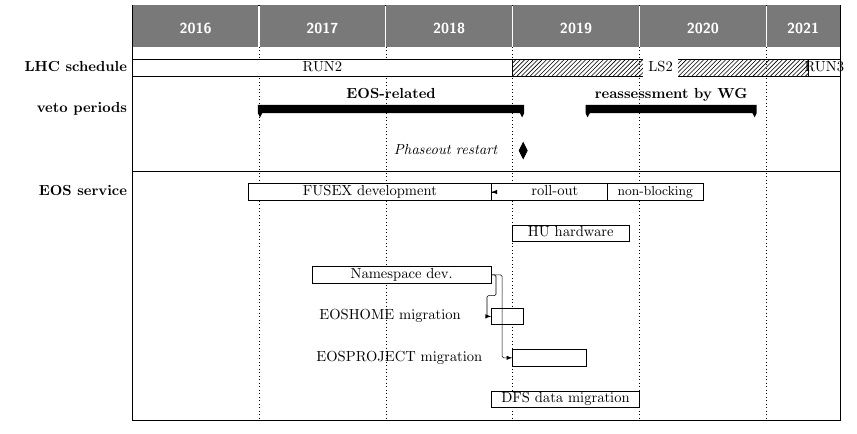
Figure 5: migration veto